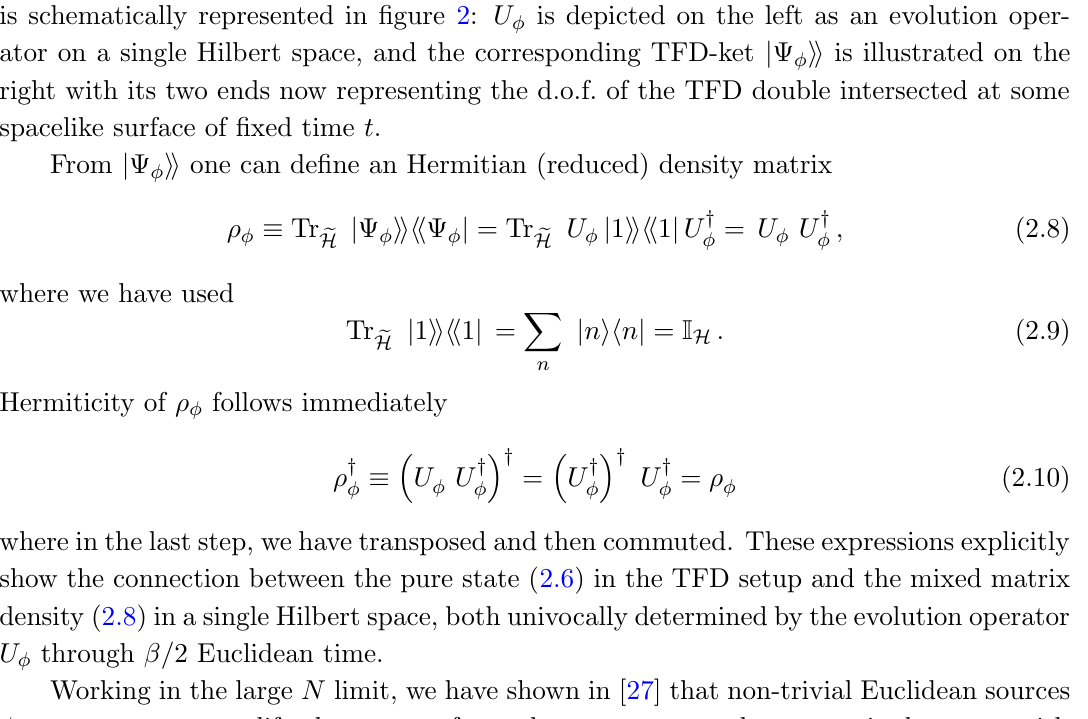
(cid:10) I ) j 1 ii = U h ~ m j 1 ii = U j m i . Expression (2.5) (cid:30) (cid:30) (cid:30) is depicted on the left as an evolution oper- (cid:30) ii is illustrated on the (cid:30)